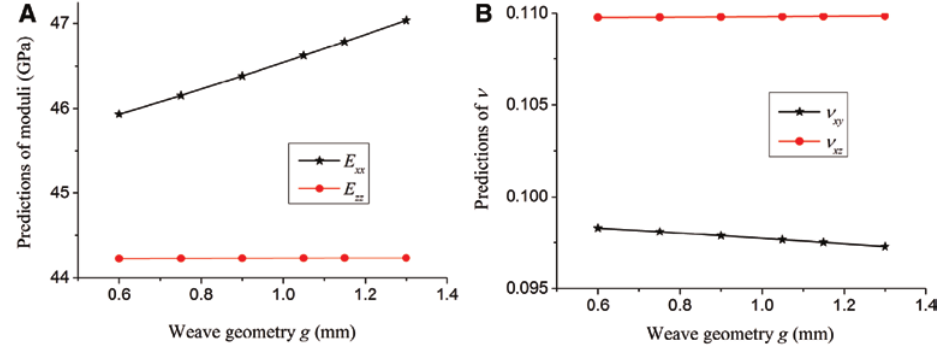
Figure 22: Effect of g on predicted values.